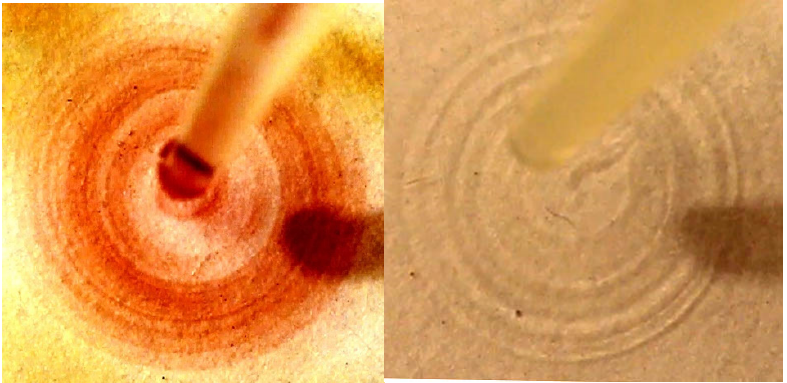
Figure 22. (Left panel) : The photo image of a ring-like structure obtained 40 ms after application of a spherical drop (0.01 mL) of an aqueous solution of Fe 2+ (10 μ M) + glutathione (0.5 M) onto a 0.3-mm layer of a 0.5 mM solution of GS-NO. The maximum diameter of the concentric rings was ~10 mm. ( Right panel) : Ring-like structures which appeared after applying a 0.01 mL drop of nitrite onto the same GS-NO solution.